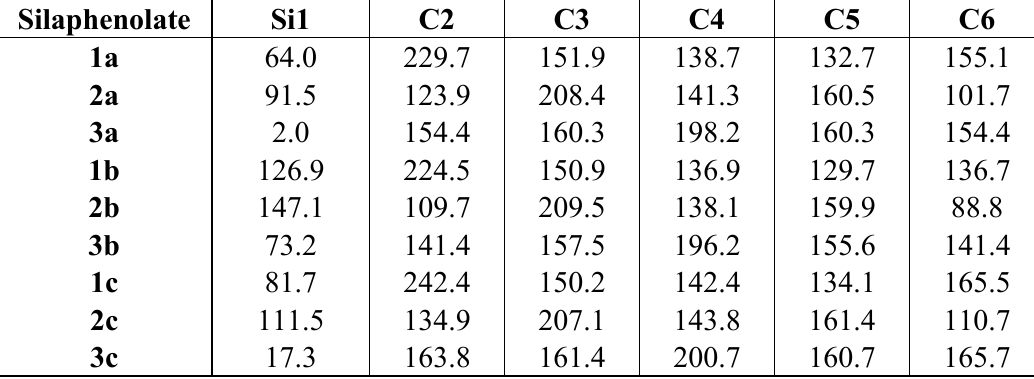
Table 4. The 13 C and 29 Si-NMR chemical shifts of silaphenolates 1a – 3c a